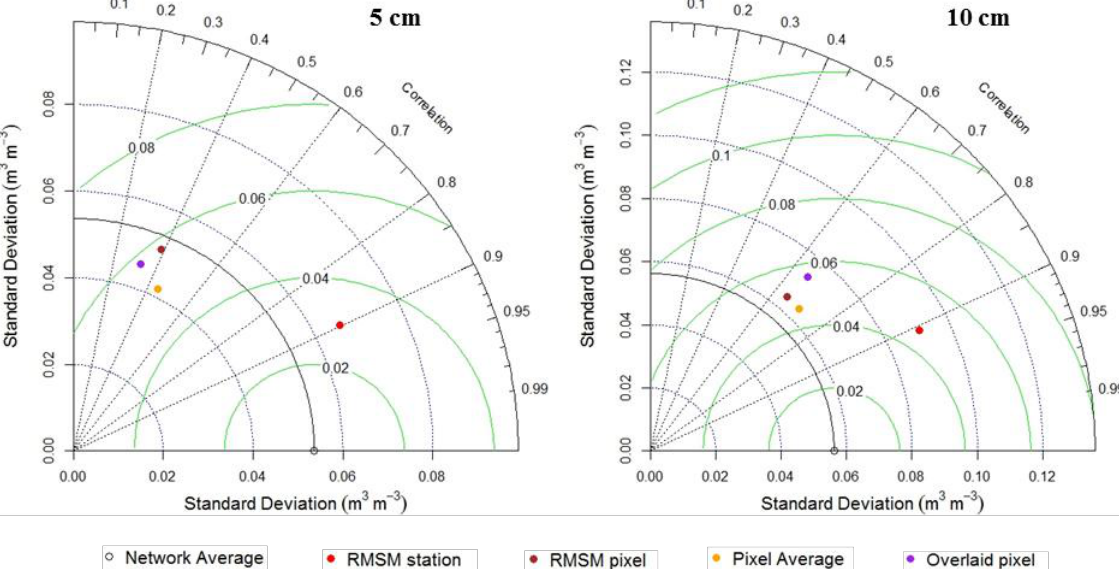
Figure 10. Taylor diagram illustrating statistics of the comparison between RMSM station, RMSM pixel, pixel average, pixel overlay on the RMSM station and the network average (the bench mark). The azimuthal angle represents correlation coefficient; radial distance represents standard deviation (m 3 ·m −3 ) of the soil moisture time series and green contours represent RMSE (m 3 ·m −3